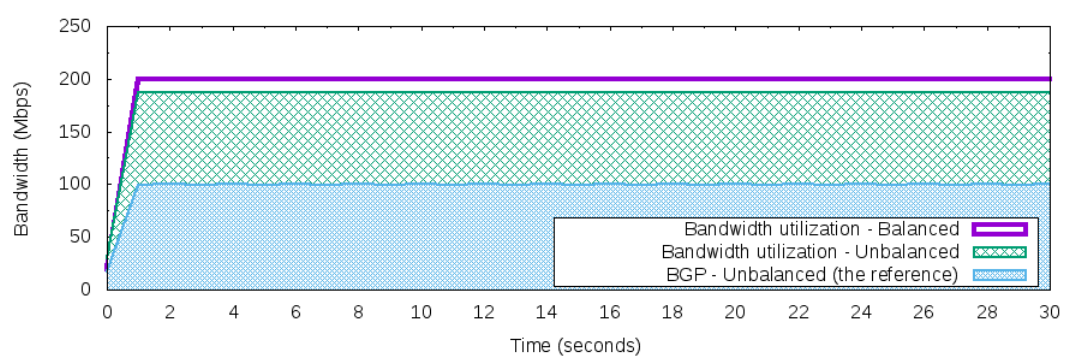
Figure 9. Round-Robin load balancer with the